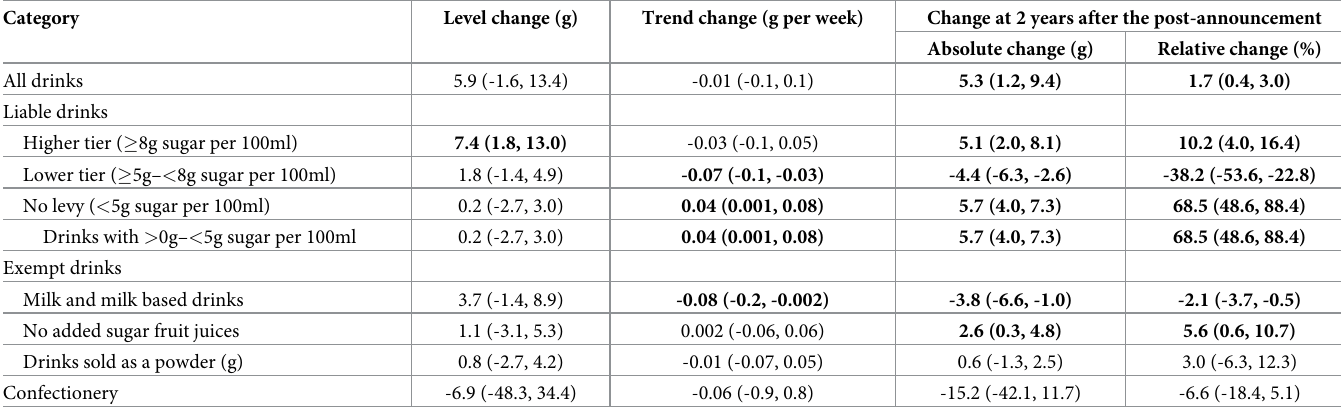
Table 3. Adjusted change in mean sugar in drinks and confectionery purchased per household per week (95% CI) (level) and adjusted change per week (trend) post-announcement of the Soft Drinks Industry Levy including toiletries as a control condition, with absolute and relative differences in purchased volume at two- years